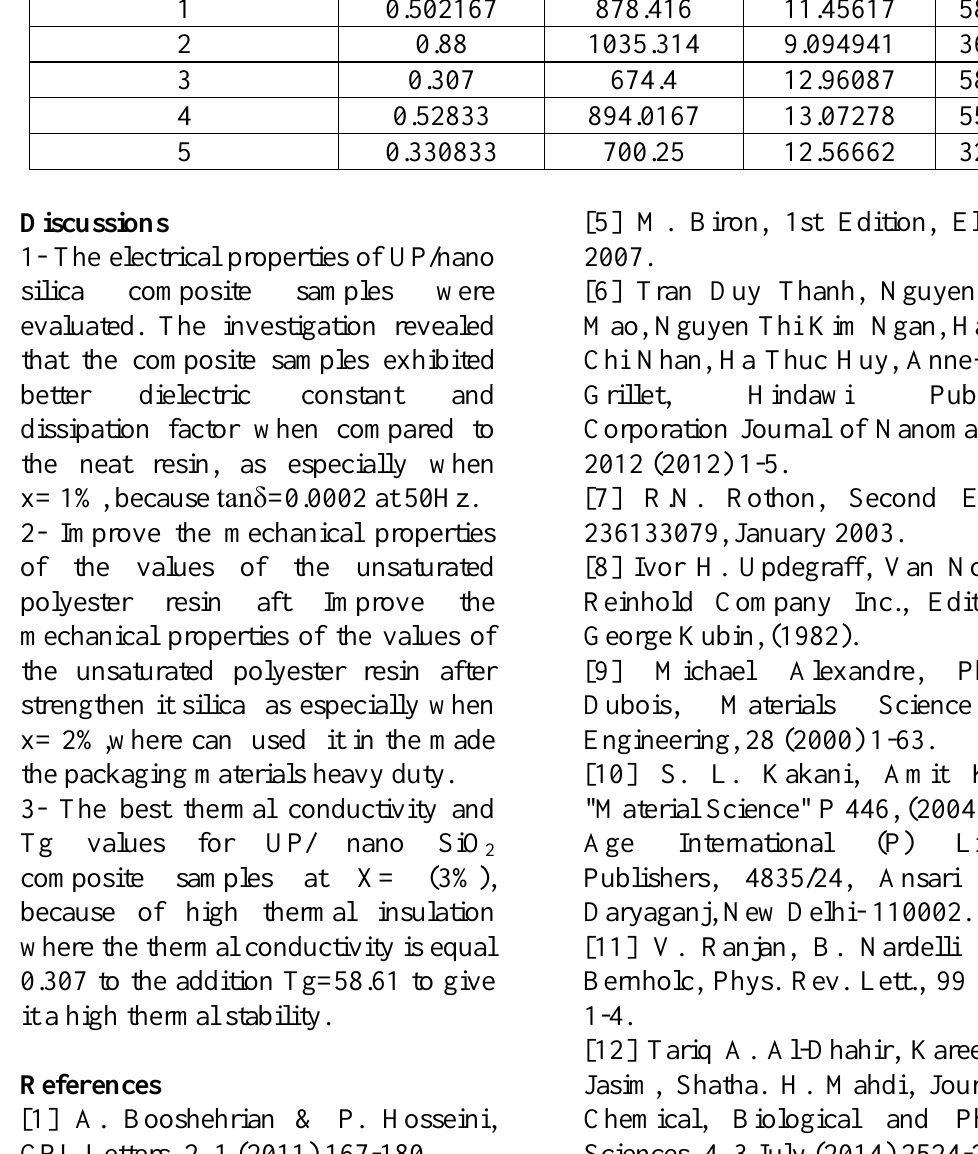
Table 5: Thermal properties (K SiO composite at X= (1, 2, 3, 4 and 2